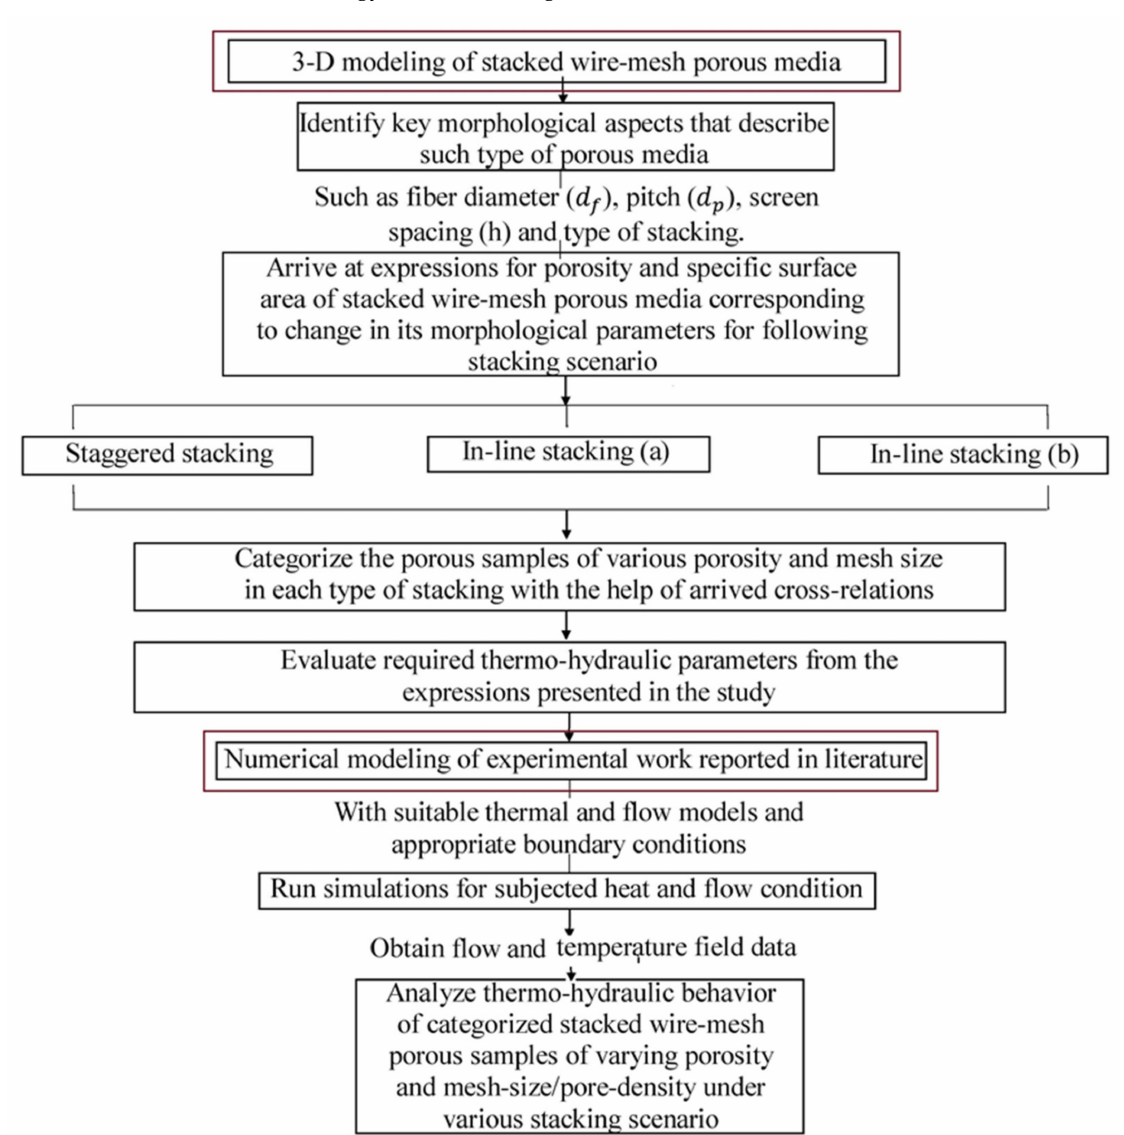
Figure 1. Chart describing the flow of the present